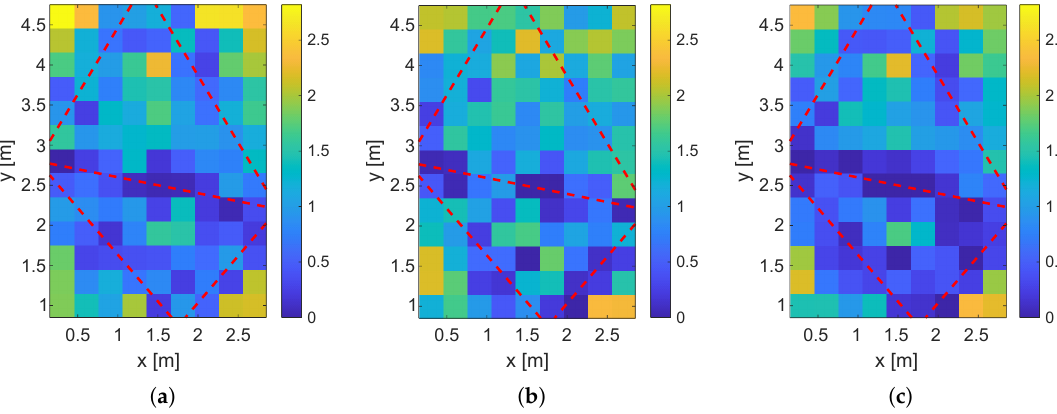
Figure 17. Mean localization error for the fingerprinting. ( a ) Measured mean of the localization error for magnitude only. ( b ) Measured mean of the localization error for phase difference only. ( c ) Measured mean of the localization error for the combined magnitude and phase